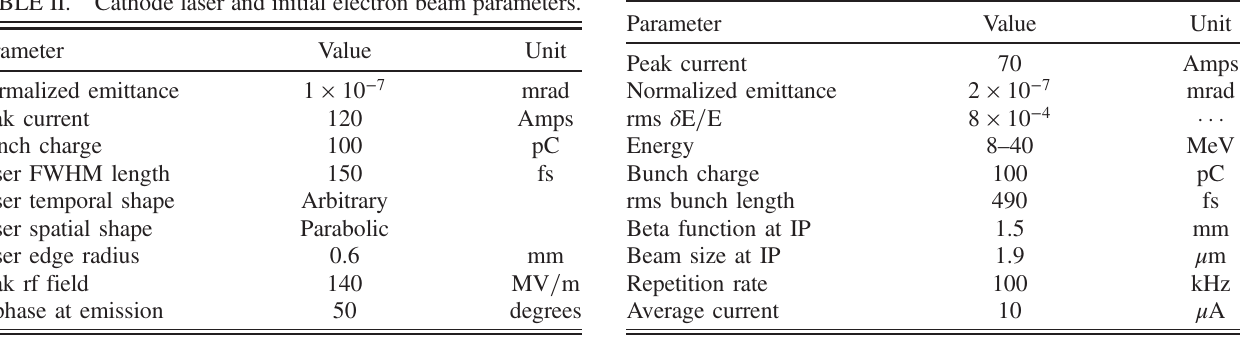
TABLE III. Electron beam parameters at laser interaction